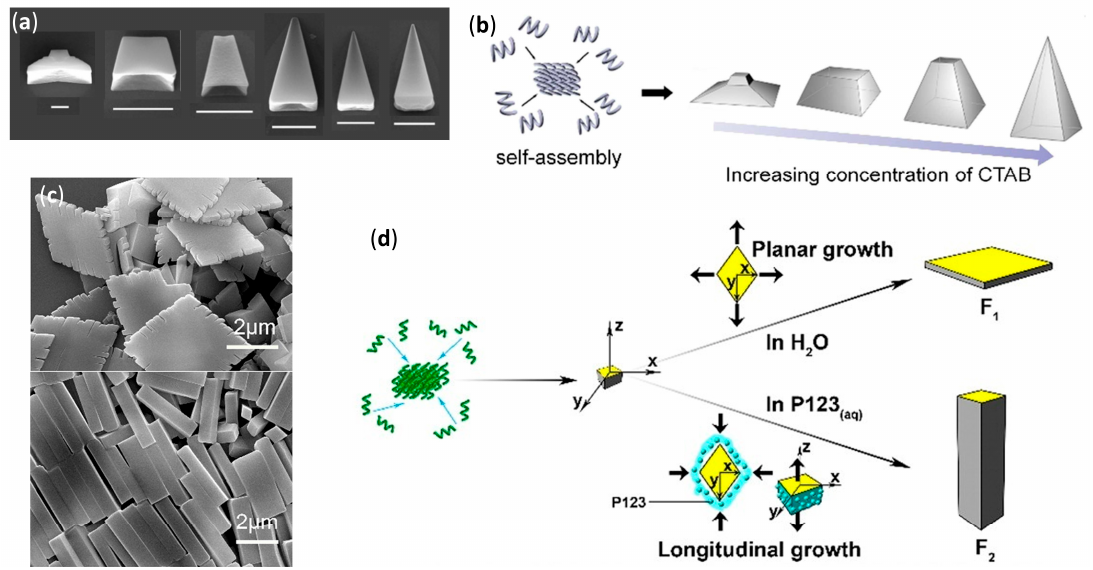
Figure 9. ( a ) SEM images of morphologies obtained from Boc-ACPC 6 -OBn in (from left to right) 0.05, 0.2, 0.3, 2, 5, and 10 g L − 1 aqueous CTAB solutions (scale bars: 1 µm, adapted with permission from Ref. [137]); ( b ) Relationship between 3D shape of a foldecture and increasing concentration of CTAB